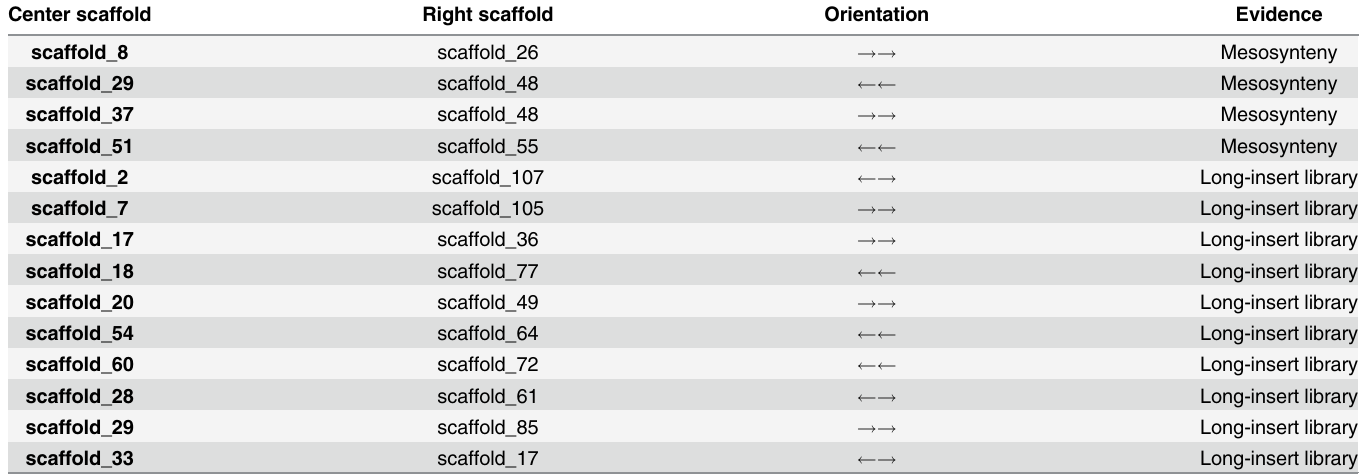
Table 2. New scaffold joins improving the P . nodorum SN15 genome assembly. Joins were either predicted by mesosyntenic patterns or by terminal matches to long insert Sanger sequence reads. Orientations are indicated relative to that of scaffolds of the original assembly. Center